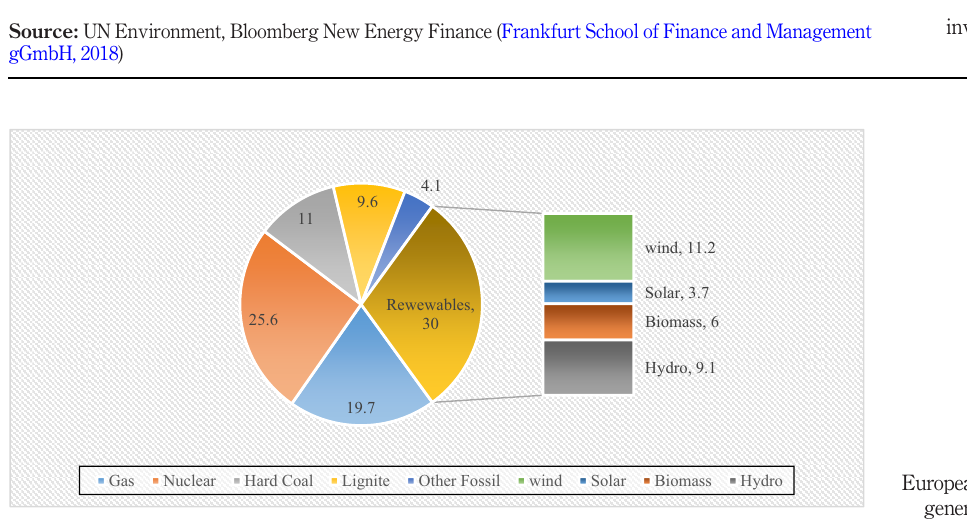
Table I. Top ten European